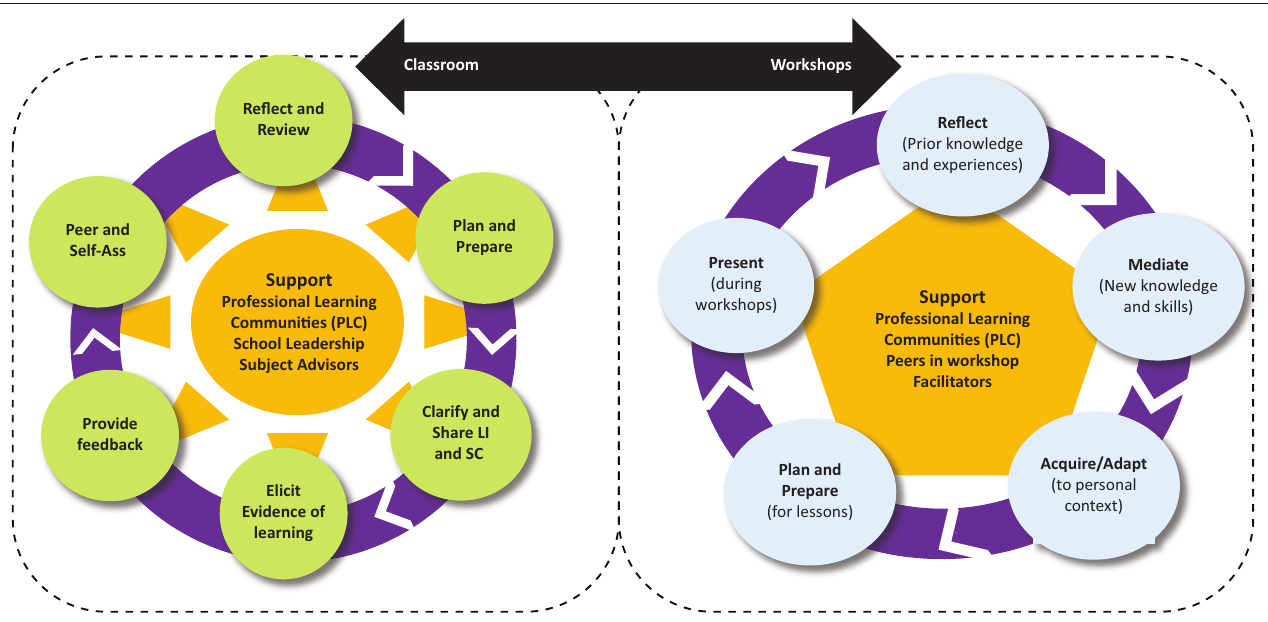
FIGURE 1: ReMAPS framework used to implement the assessment for learning in Africa project.